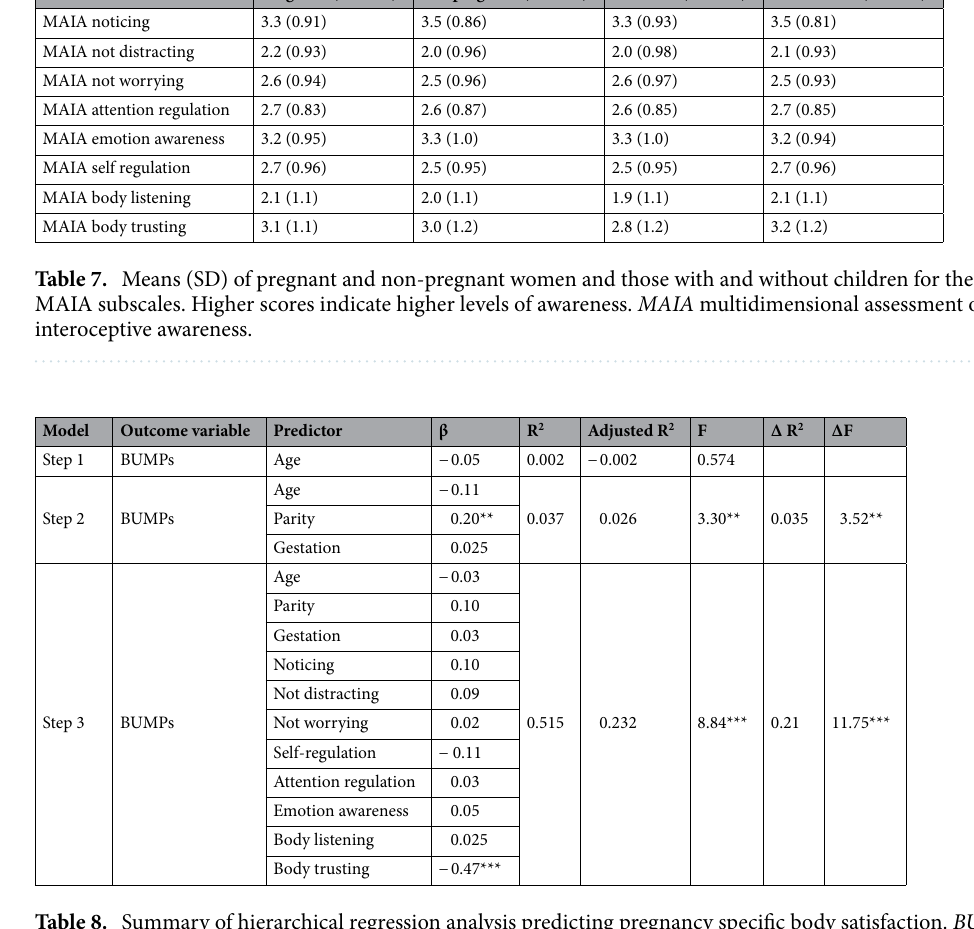
Table 8. Summary of hierarchical regression analysis predicting pregnancy specific body satisfaction. BUMPs body understanding measure in pregnancy scale. * p < 0.5, ** p < 0.01, *** p < 0.001.